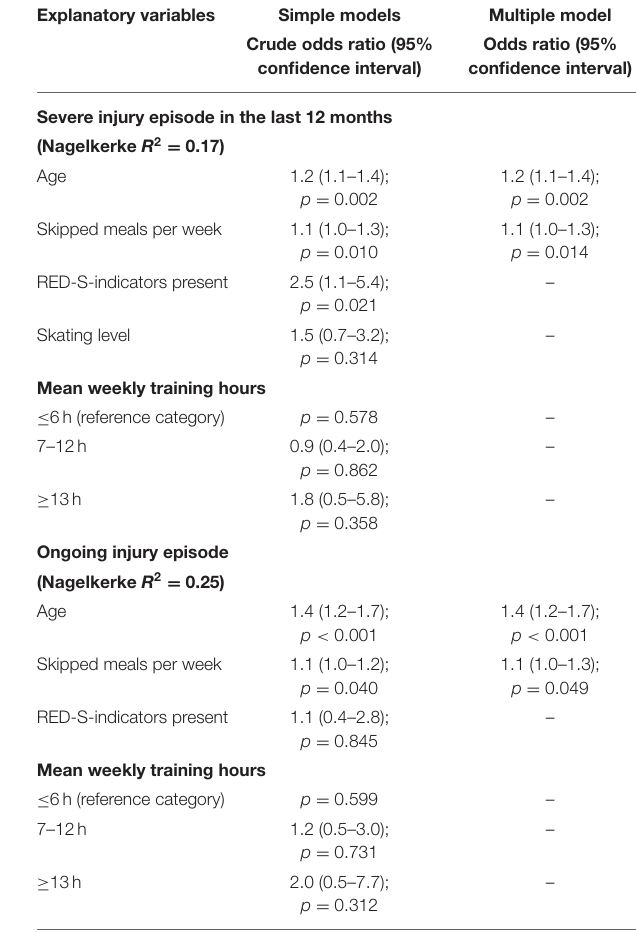
TABLE 3 | Injury determinants for the primary outcome (severe injury episode in the past 12 months, n = 42) and secondary outcome (ongoing injury episode, n = 26).